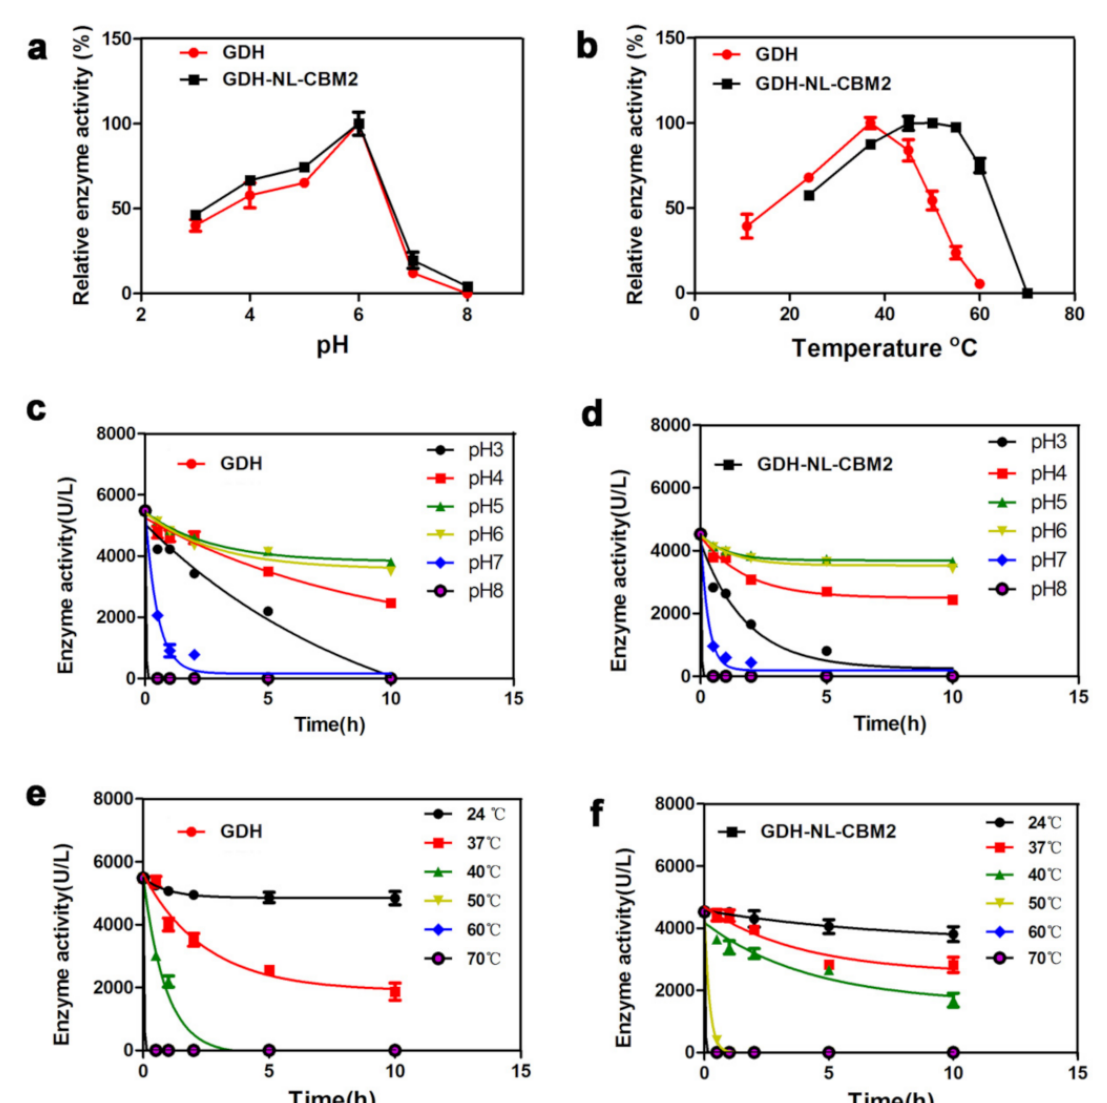
Figure 2. Determination of the optimal temperature and pH value as well as the pH and temperature stability for GDH and GDH-NL-CBM2. ( a , b ) Optimal pH and temperature of the GDH, GDH-NL-CBM2, respectively; ( c , d ) pH stability for the GDH and GDH-NL-CBM2, respectively; ( e , f ) Temperature stability for GDH and GDH-NL-CBM2,